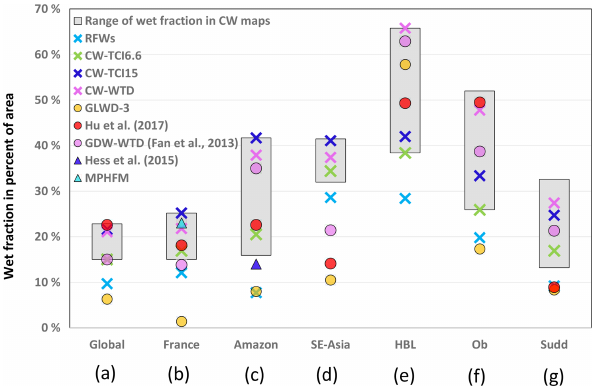
Figure 11. Total wet fractions for RFWs, different CW and valida- tion datasets, at the global scale and in the studied regions (values in percent of the corresponding land surface area). Only three CW maps are shown in color, and others are displayed in the grey